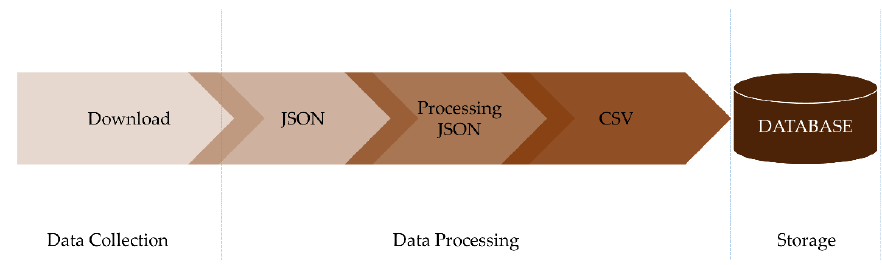
Figure 3. The process flow for data acquisition. CSV: comma-separated values.